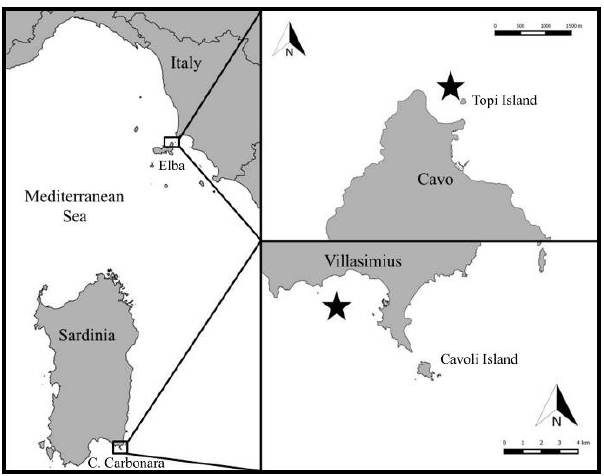
Figure 1. Localization of the two transplant